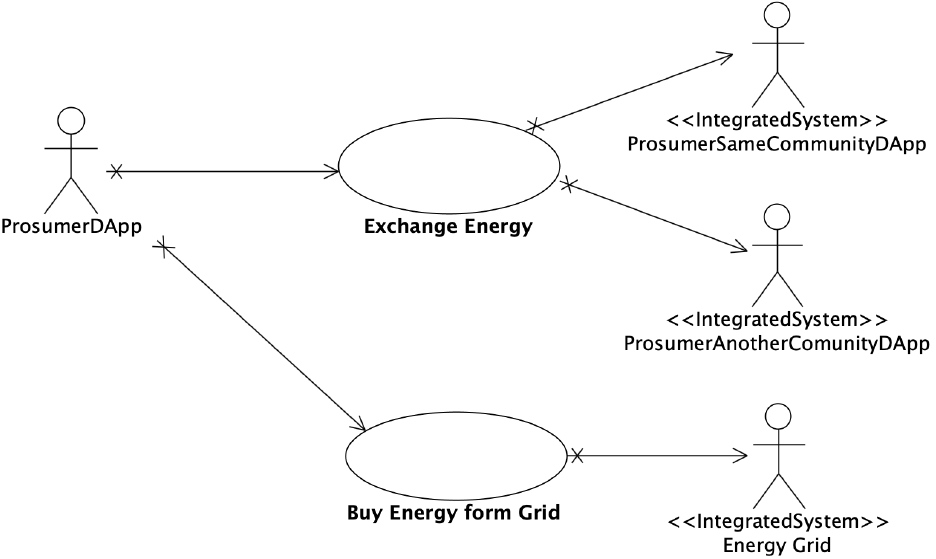
Figure 1. The UML use case diagram for renewable energy use cases/smart